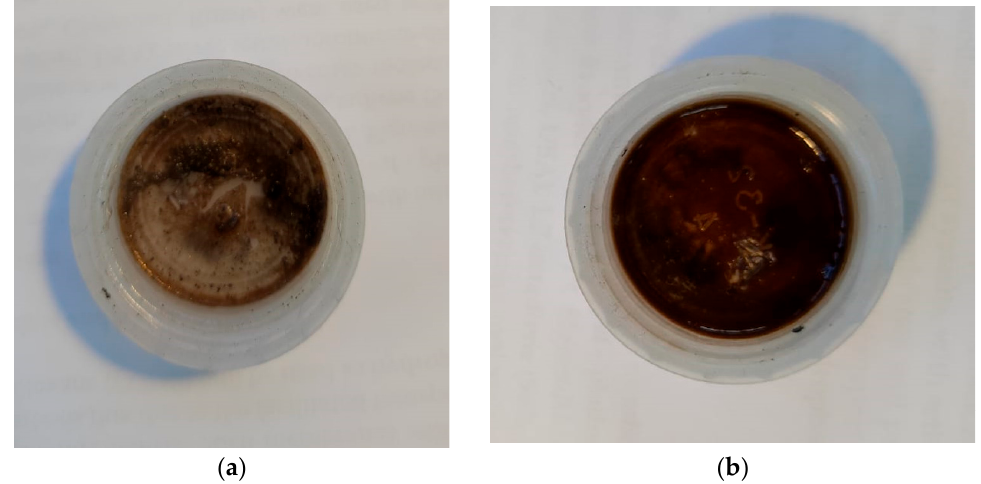
Figure 3. Types of POMS polymer films with the addition of a silver salt: ( a ) AgNO 3 , ( b ) AgBF 4 . POMS films with different AgBF 4 contents were obtained from 1 to 50 wt%. When